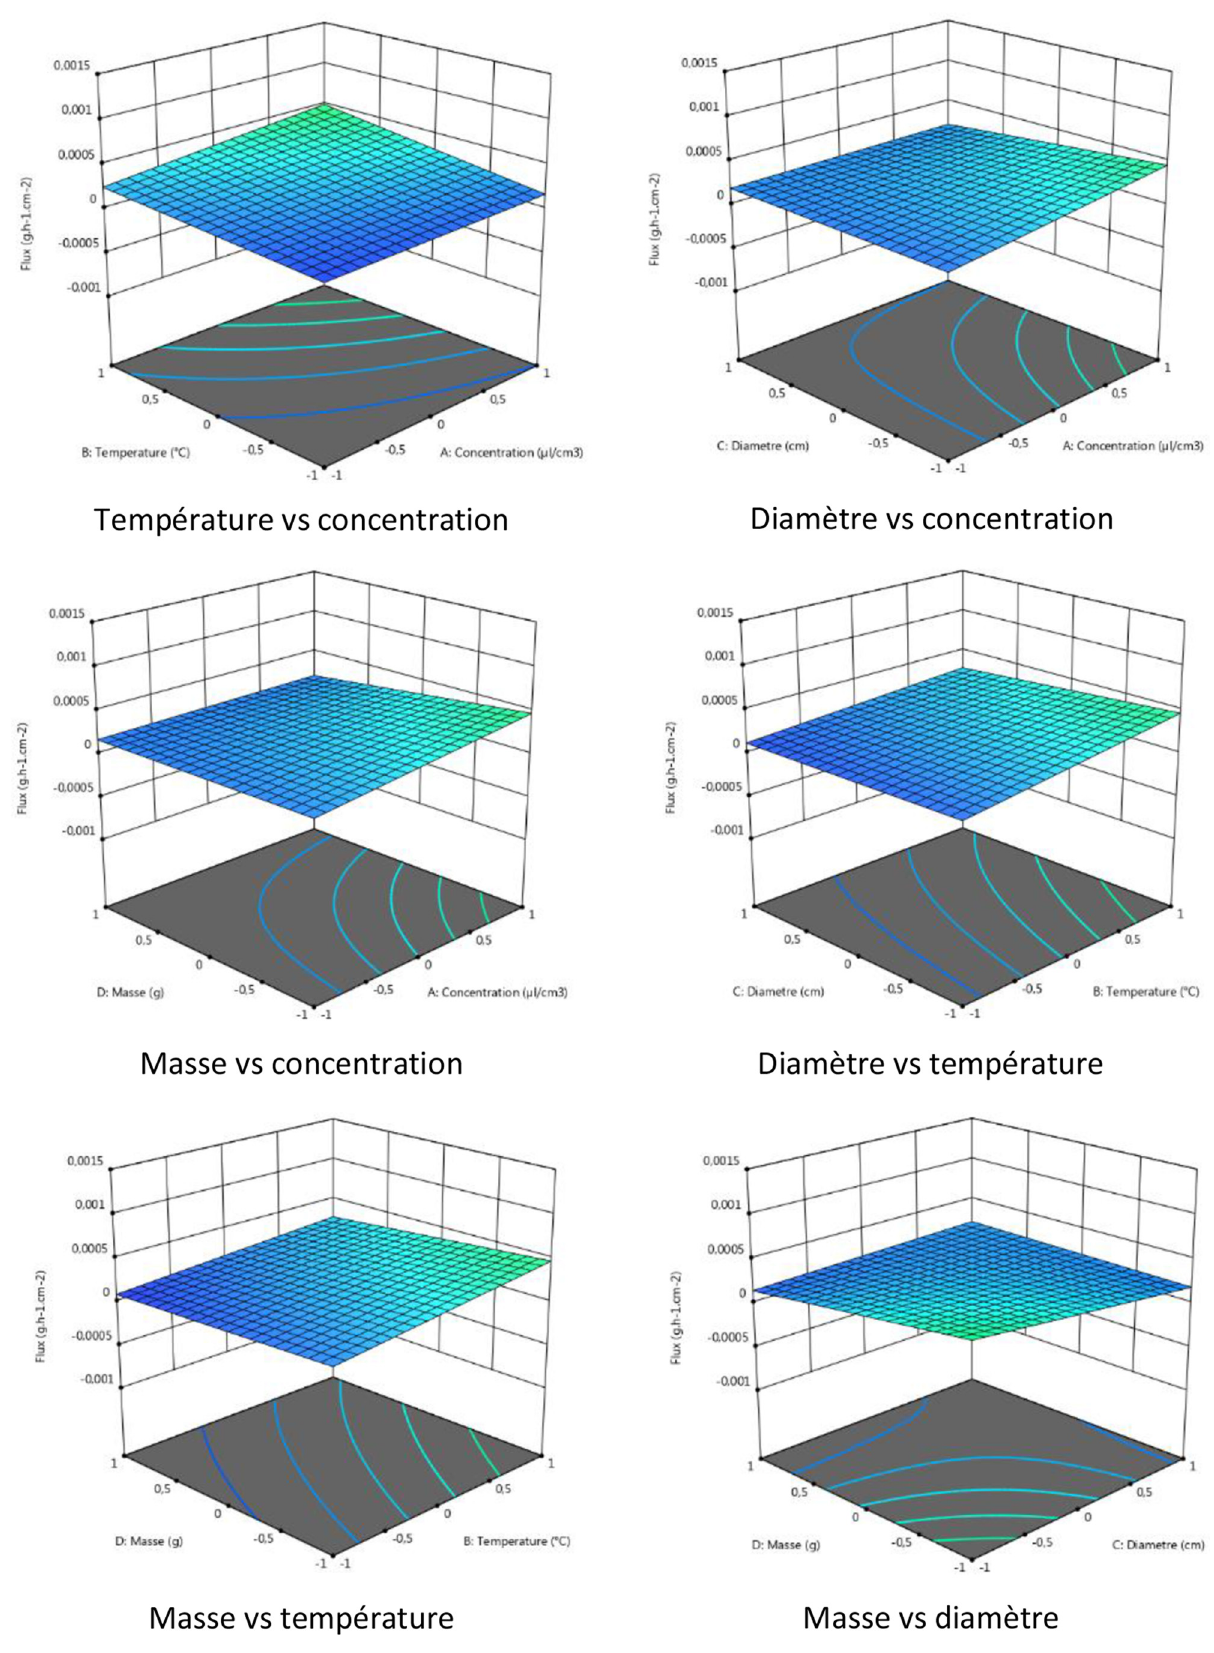
Fig. 2. 3D representation of fl ow as a function of two